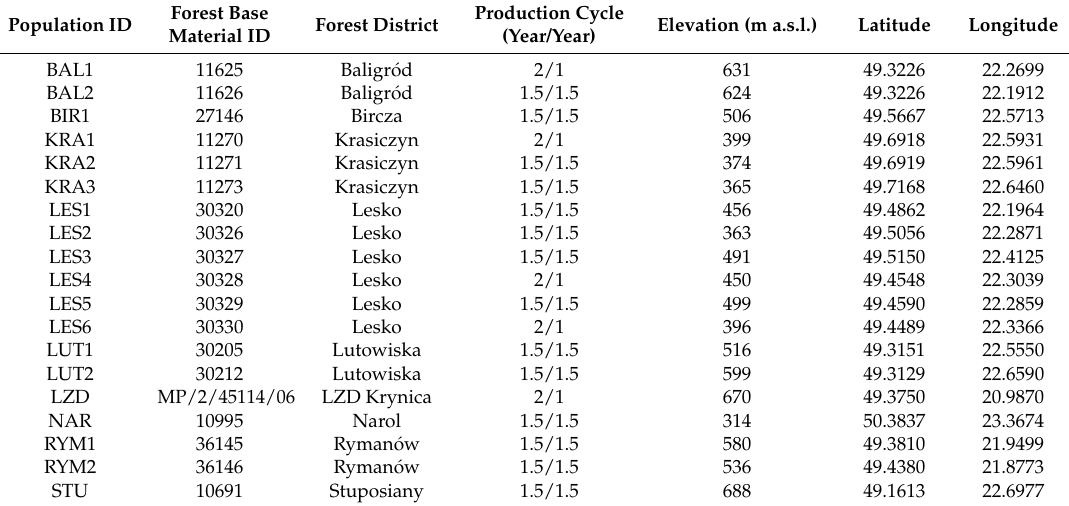
Table 1. Characteristics of the tested silver fir populations. Production cycle: 1.5/1.5 (after replanting for 1.5 years) and 2/1 (after nurturing for two years); latitude and longitude in WGS84 expressed in decimal degrees